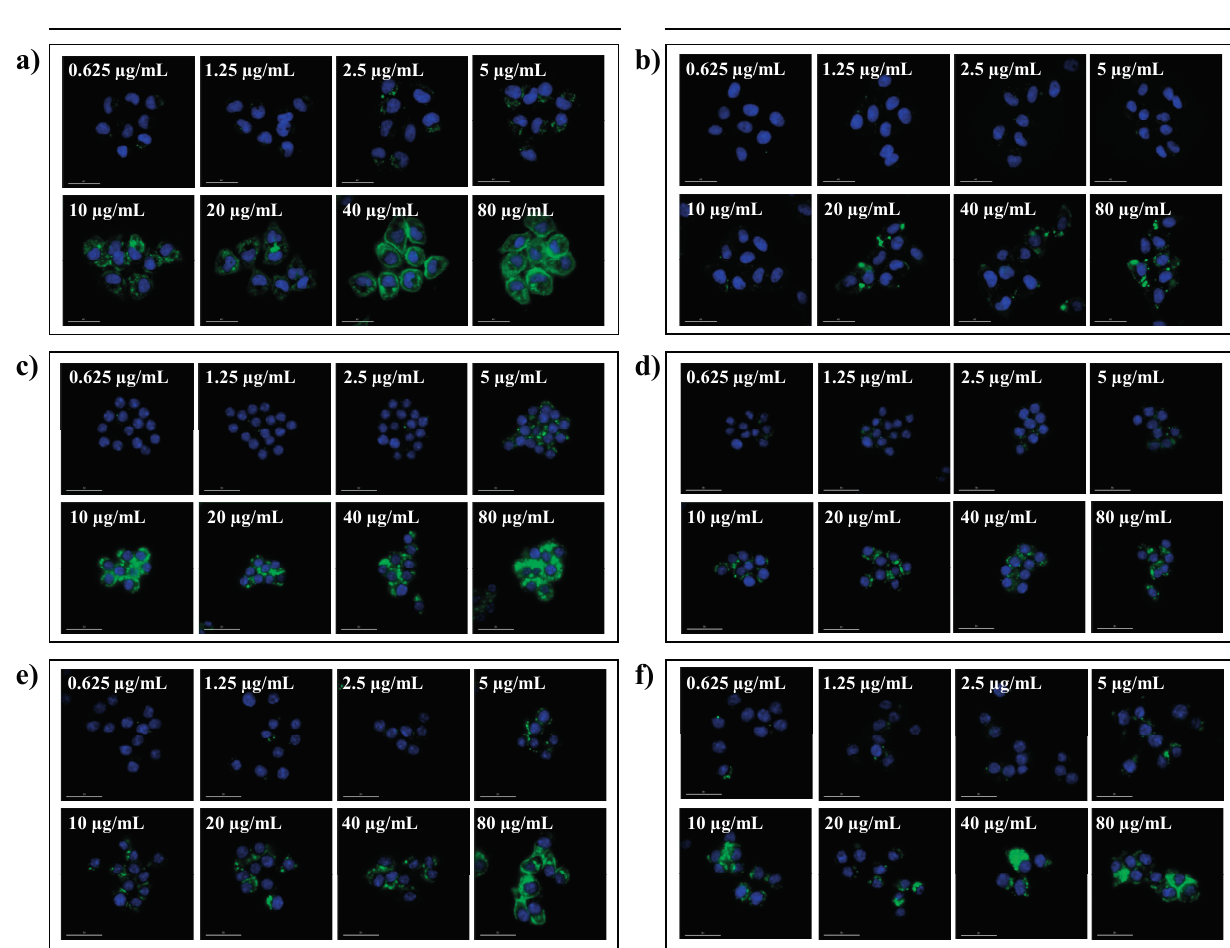
Figure 8. Fluorescence microscope images of γ -PGA/PLL (left) and γ -PGA/Chitosan (right), respectively (( a , b ) HeLa cells, ( c , d ) RAW264.7 cells, ( e , f ) DC2.4 cells). The two types of nanocomposites were incubated with various concentrations (from 0.625 µg/mL to 80 µg/mL) for 24 h. (Ex 490/20; Em